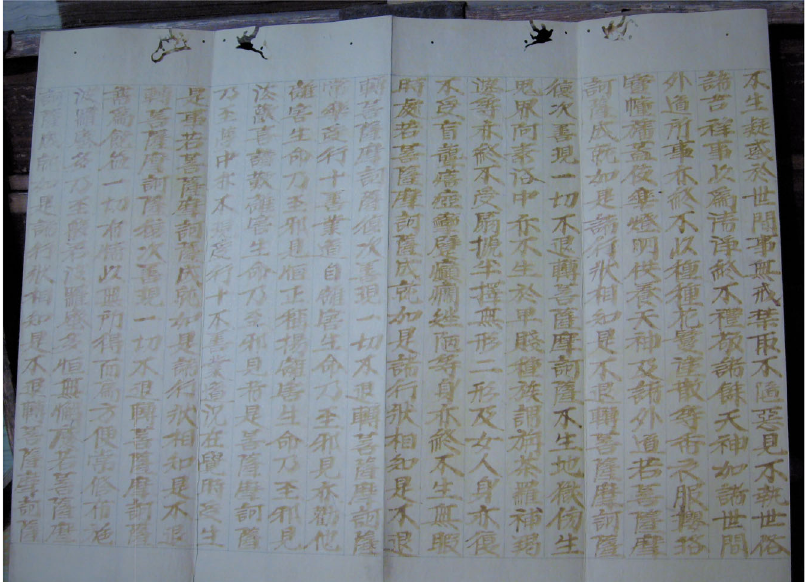
Fig. 5 A four-page spread of the Da bore poluomi jing 大 般若 波 羅 蜜 經 (skt. Mah ā prajñ ā p ā ramit ā -s ū tra ) in 600 fascicles in 700 accordion bound books written by three generations of monks in the Japanese S ō t ō School. This spread measures 10 x 17 inches. The project started with Gekkan Gik ō 月 澗 義 光 (1653 – 1697) and was fi nished in 1737 by Kigai Reij ō 規 外 霊 長 . Currently, it is housed in Fuzai-in in Noto Peninsula, Japan. Photograph by the